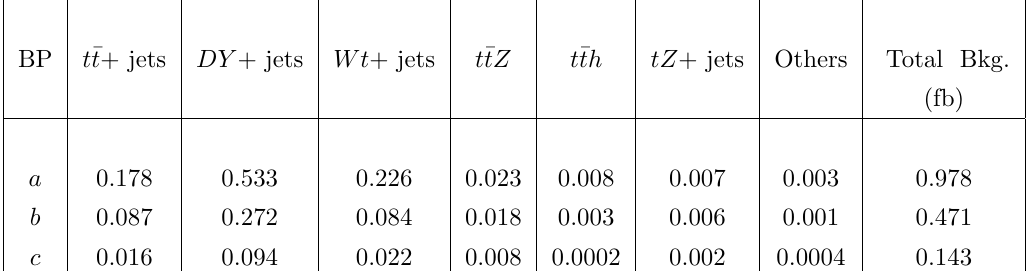
Figure 6 . The normalized m ‘‘bb distributions of the signal and leading backgrounds for the bZh process.